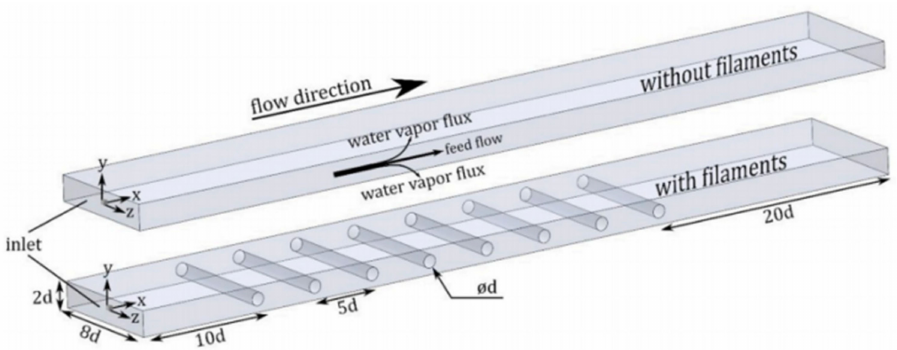
Figure 10. Schematic of Flow Geometry without and with filaments [17]. Reproduced with permis- sion from Elsevier,